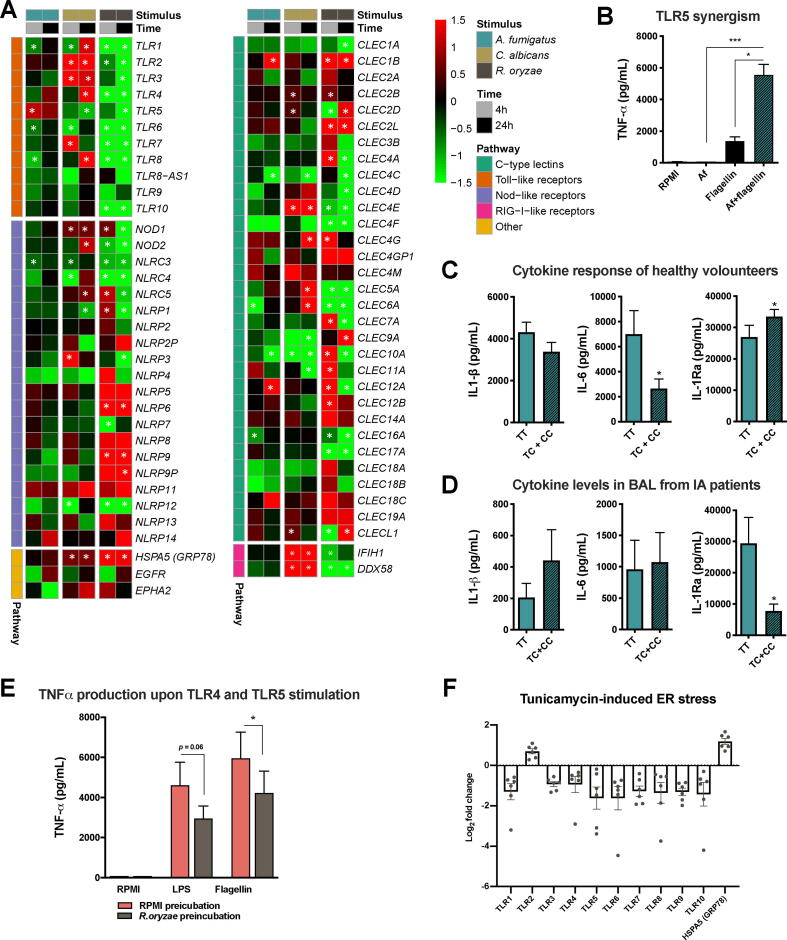
Regulation of Pattern Recognition Receptors and species-specific features: TLR5 in A. fumigatus-induced cytokine production and R. oryzae-induced downregulation of TLR signaling (A) Heatmap of transcriptional expression of Toll-like receptors (TLR), C-type lectin receptors (CLR) and NOD-like receptors (NLR) family members and GRP78 extracted from the RNA-Seq dataset of PBMCs stimulated with A. fumigatus, C. albicans and R. oryzae for 4 h and 24 h compared to unstimulated cells (RPMI); the color indicates the Log2FC (Shades of red indicate upregulation, while shades of green downregulation, see legend; the white * indicates adjusted p-value < 0.05). (B) TNF release in culture supernatants of PBMCs from healthy volunteers stimulated for 24 h with A. fumigatus V05-27 conidia (1 × 107/mL), flagellin (1 µg/mL), or flagellin following 1 h of pre-incubation with A. fumigatus conidia; all stimulations were in the presence of 10% human serum. Data are represented as mean ± SEM and means were compared using the Kruskal Wallis test with Dunn’s multiple comparison test, p-values of statistical tests are shown within the graphs (n = 12; *p < 0.05; ***p < 0.001). (C) IL-1β, IL-6, IL-1Ra release in supernatants of PBMCs from healthy volunteers after stimulation for 24 h with A. fumigatus V05-27 heat-killed conidia (1 × 107/mL). The cytokine responses were compared by stratifying for the homozygous or heterozygous presence of the C allele for TLR5 variant (rs5744174; n = 12 TT, n = 36 TC + CC). Data are represented as mean ± SEM and means were compared using the Mann Whitney U test, p-values of statistical tests are shown within the graphs (*p < 0.05). (D) Concentrations of IL-1β, IL-6, IL-1Ra measured in BAL samples of IPA patients, which were stratified according to the genotypes for the TLR5 variant (rs5744174; n = 11 TT, n = 8 TC + CC). Data are presented as mean ± SEM. (E) TNF release in the culture supernatant of PBMCs from healthy volunteers (n = 6 donors) pre-incubated with R. oryzae (PFA fixed, 1 × 107/mL) for 2 h in the presence of 10% serum and subsequently re-stimulated with 10 ng/mL E. coli LPS (TLR4 agonist) and 1ug/mL Flagellin (TLR5 agonist) (mean ± SEM). *p < 0.05, Wilcoxon signed-rank test. (F) Expression of TLR1-10 and GRP78 quantified by qRT-PCR in PBMCs from healthy volunteers (n = 6 donors) under Tunicamycin-induced ER stress for 4 h, as compared with untreated cells. Log-fold changes are expressed as the ratio of gene expression, after normalization to β-actin. (For interpretation of the references to color in this figure legend, the reader is referred to the web version of this article.)